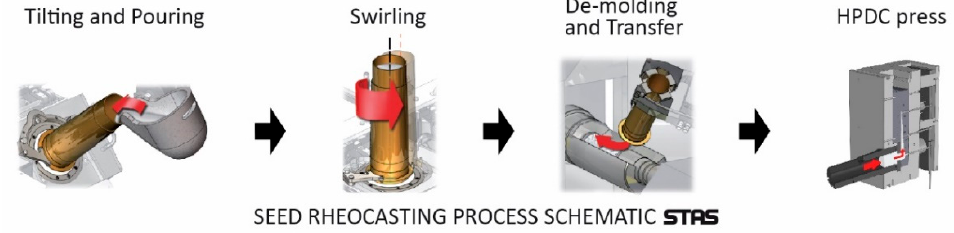
Figure 3. The Swirling Enthalpy Equilibration Device (SEED) process (Courtesy STAS)